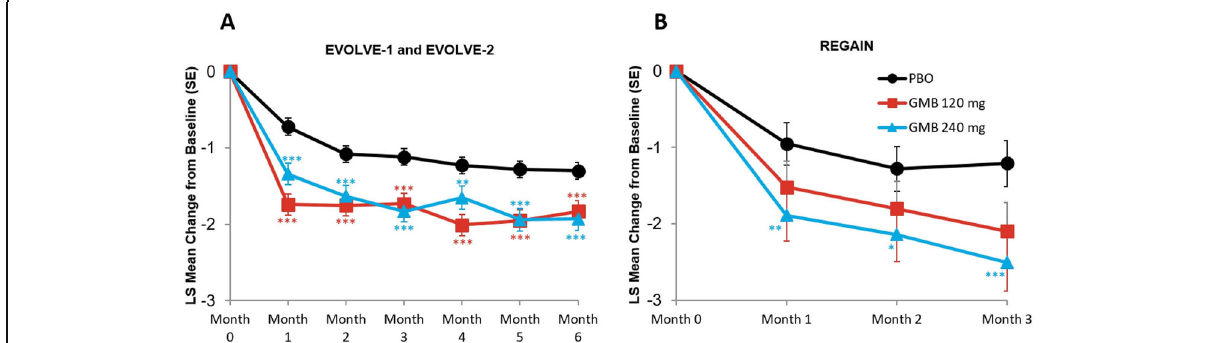
Fig. 3 Monthly mean change in monthly migraine headache days with prodromal symptoms. * p ≤ 0.05 vs PBO; ** p ≤ 0.01 vs PBO; *** p ≤ 0.001 vs PBO. GMB, galcanezumab; LS,least squares; PBO, placebo; SE, standard error